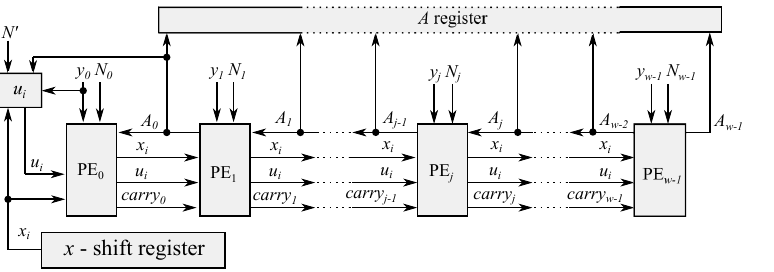
Figure 1. Block diagram of the systolic architecture for Montgomery multiplication in FPGA.